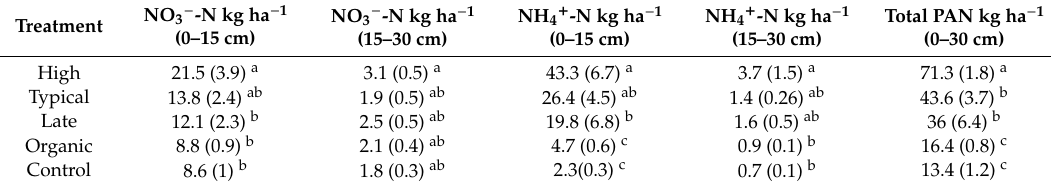
Table 1. Seasonal averages for nitrate (NO 3 − -N) and ammonium (NH 4 + -N) at the 0–15 and 15–30 cm depths, and total plant available nitrogen (PAN) for 0–30 cm and associated standard errors in brackets (n = 32) for High fertilizer (High), Typical fertilizer (Typical), Late incorporation (Late), Organic and Control